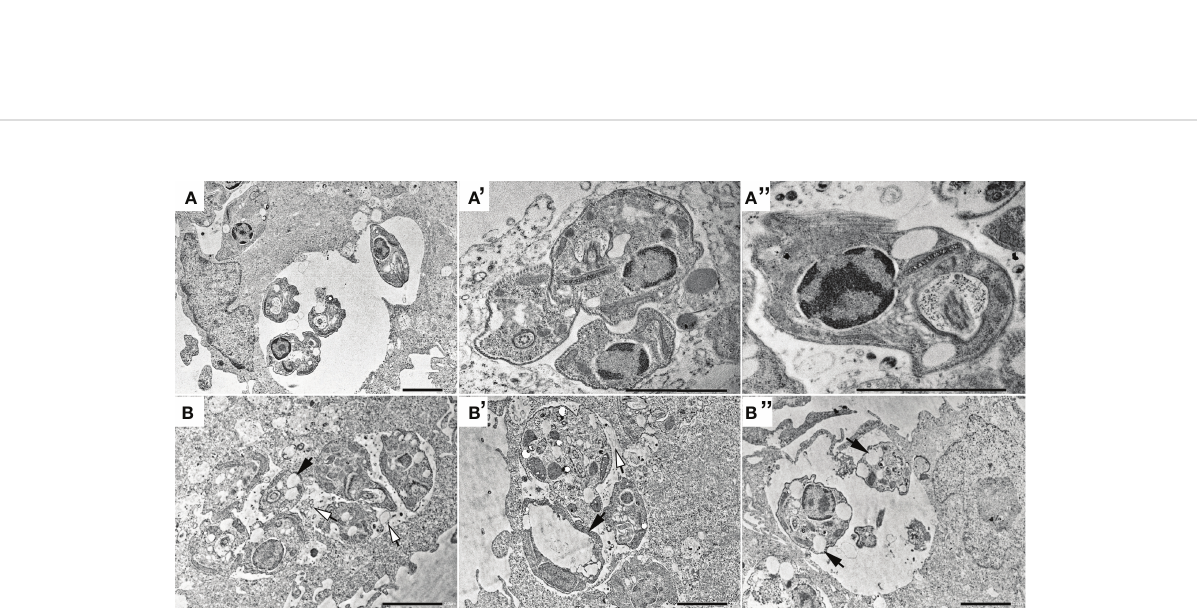
FIGURE 6 Transmission electron microscopy of non-treated intracellular amastigotes ( A , A ’ and A ’’ ) and treated with 50 m M of TCBZ ( B , B ’ and B ’’ ). Black arrows point to several large vesicles in treated parasites, both in AmpB and TCBZ treatment, absent in control. Also, treated samples seems to present possible cellular debris inside the parasitophorous vacuole (white arrowheads), indicating parasite death. Bars: 2 m